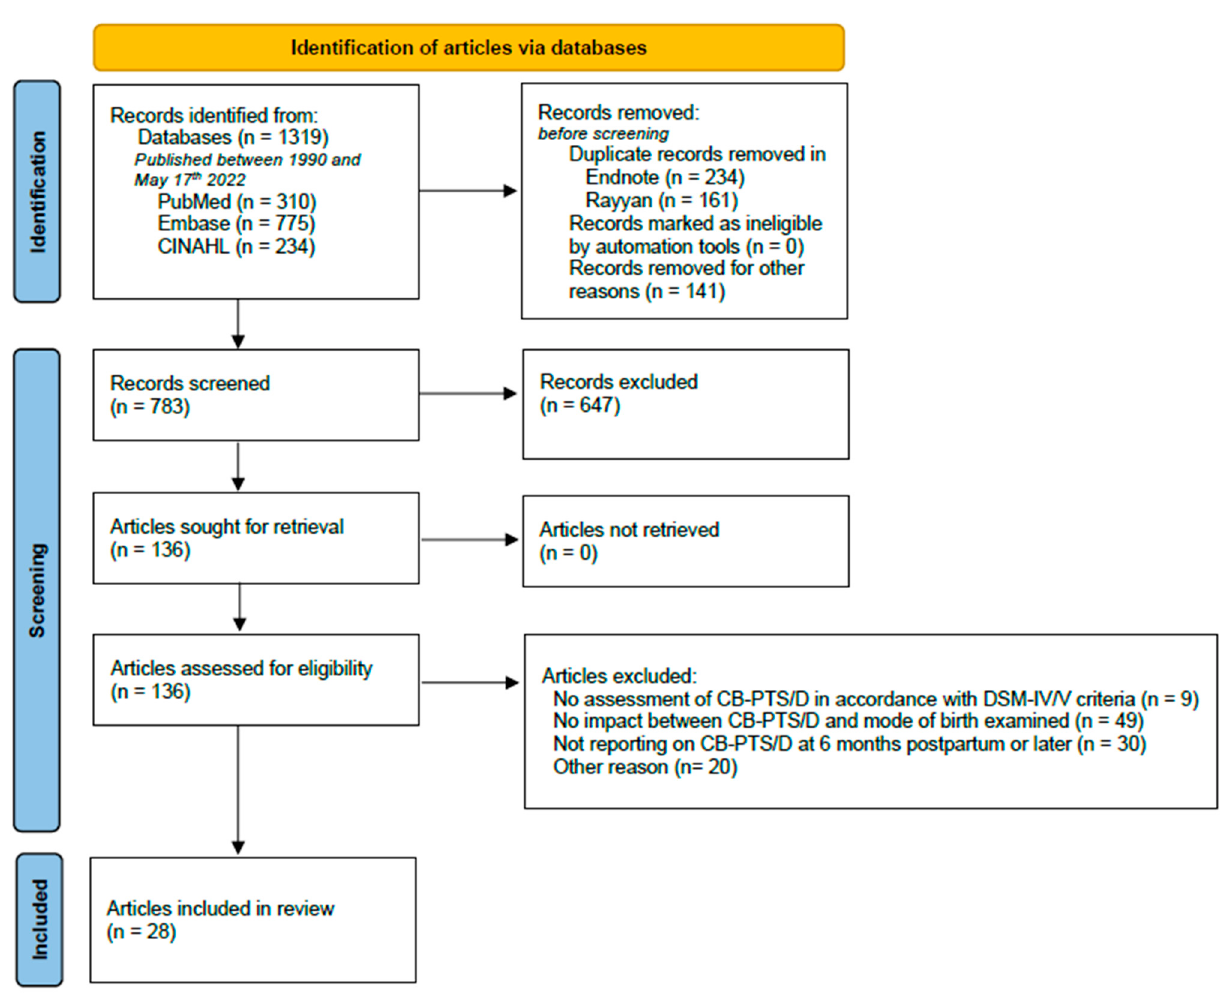
Figure 1. PRISMA flowchart illustrating the systematic database search and extraction of articles that met the inclusion criteria (MOB: mode of birth).